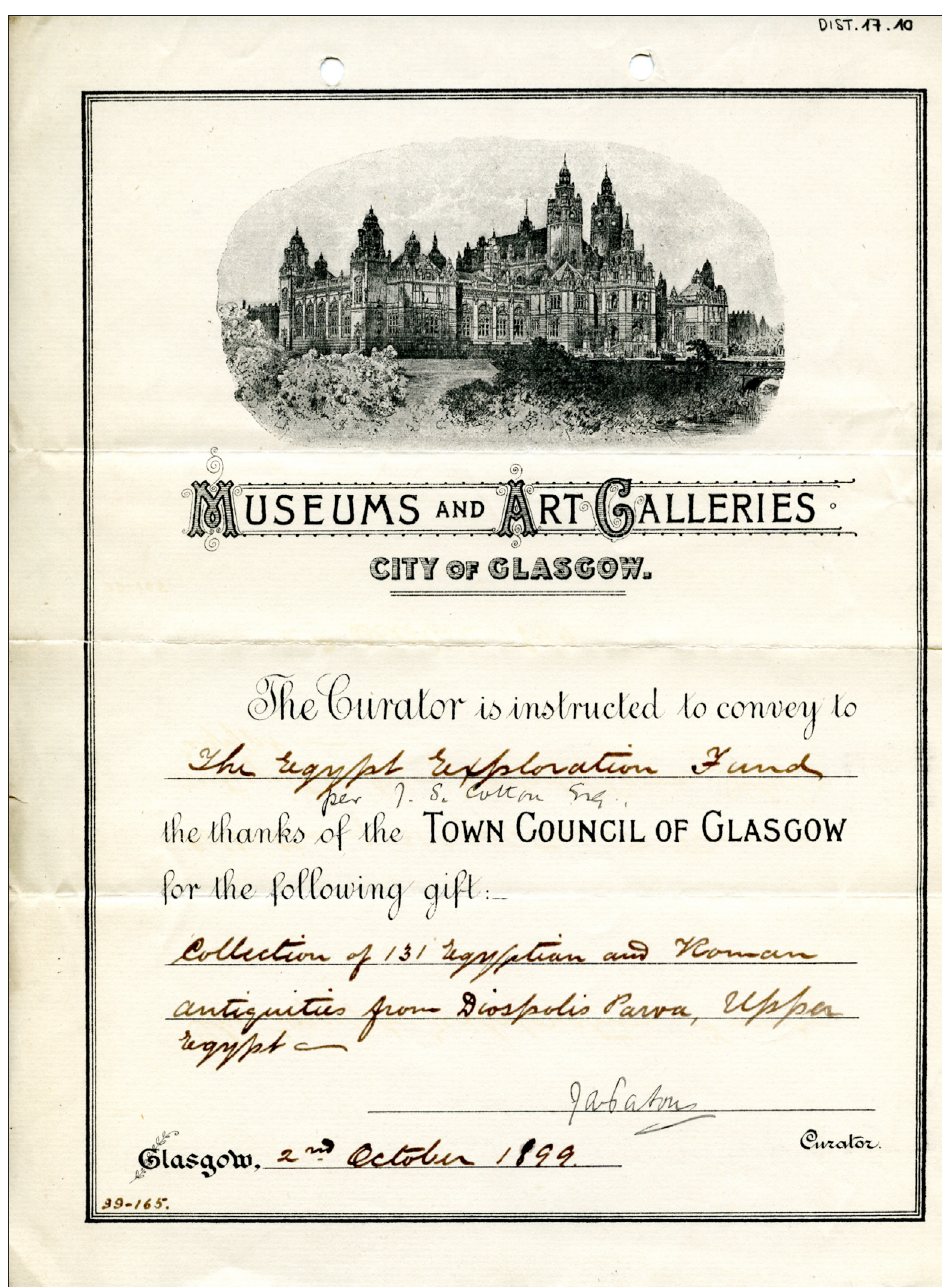
Figure 2: Letter from Glasgow Museums dated 1900, acknowledging material from excavations at Diospolis Parva. (Photo Egypt Exploration Society, Lucy Gura Archive (Dist